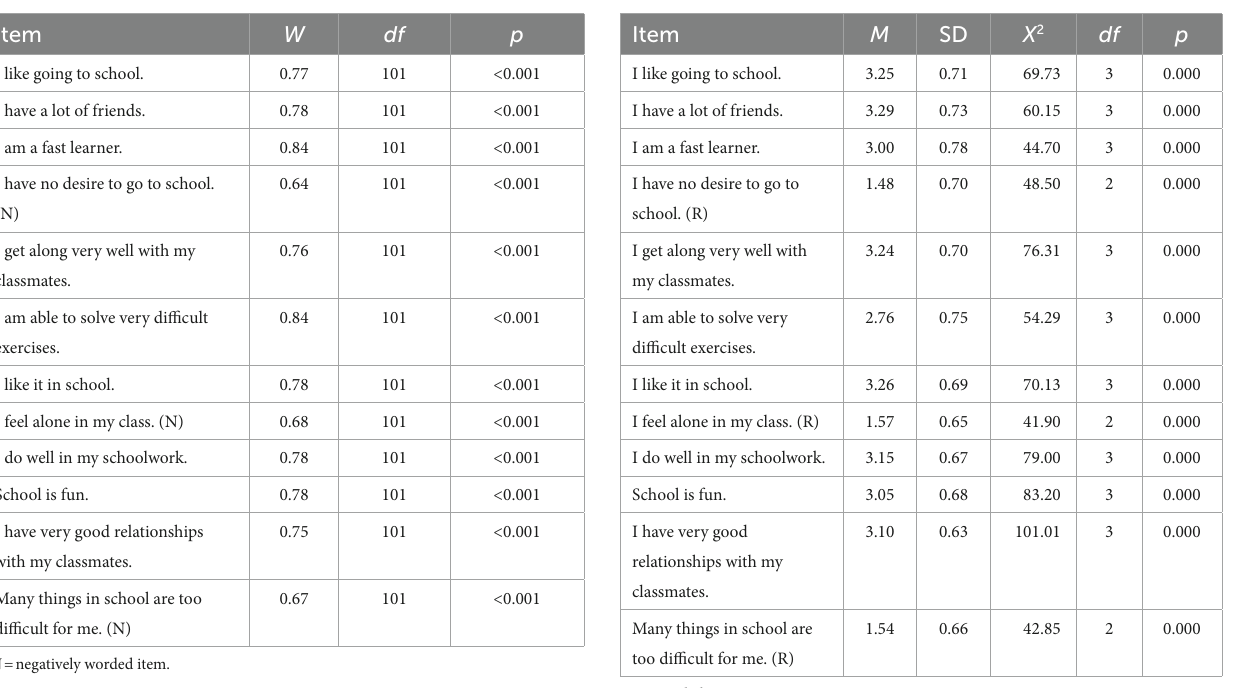
TABLE 1 Shapiro–Wilk test for each of the 12 items of the PIQ ( N = 101). TABLE 2 Means, standard deviations, t-statistics and effect size ( N =